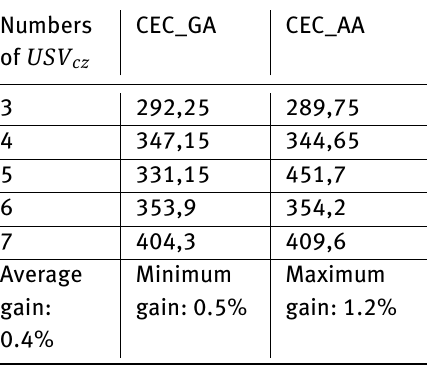
Table 2: Displacement-cleaning energy consumption for a zone with a strong degrees of